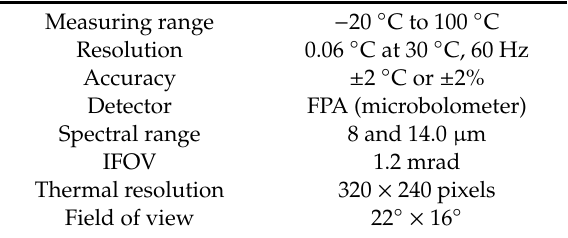
Table 2. Main specifications of the infrared (IR) camera.